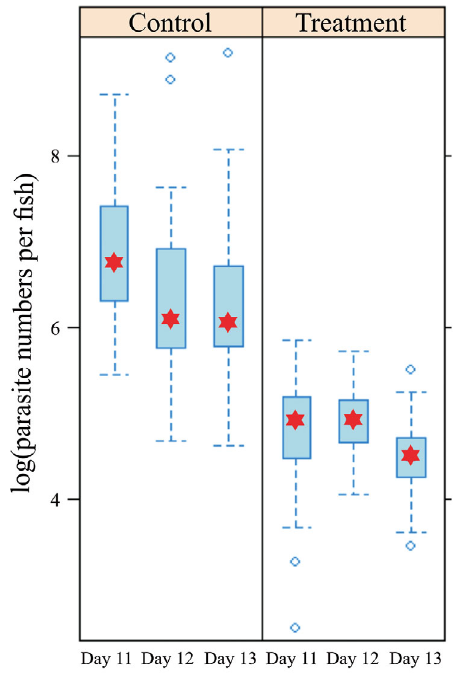
Fig. 4. Effect of Lysmata vittata on the number of Neobene- denia girellae infecting juvenile Epinephelus lanceolatus . Red star: median; boxes are standard 50% interquartile range; clear circles: outliers generated by the analysis; day: day